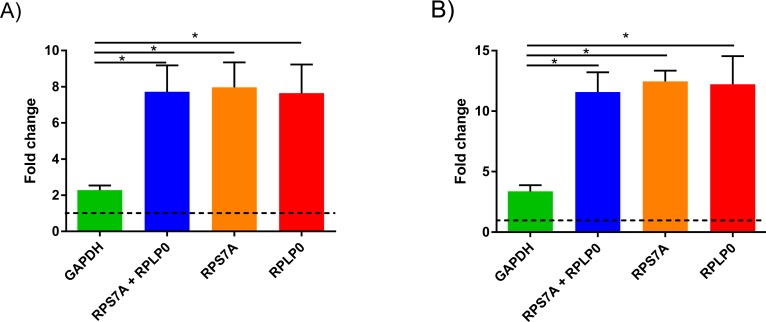
KRT17 levels in precancerous and lesional NMSC.Comparison of relative quantitation analysis of KRT17 levels in AK (A) and SCC (B) lesions using either RPS7A/RPLP0 or GAPDH as the reference gene relative to non-photodamaged skin. Data are presented as mean ± SEM, n = 3, ∗ indicates P < 0.05; one-way ANOVA and Turkey post-test.